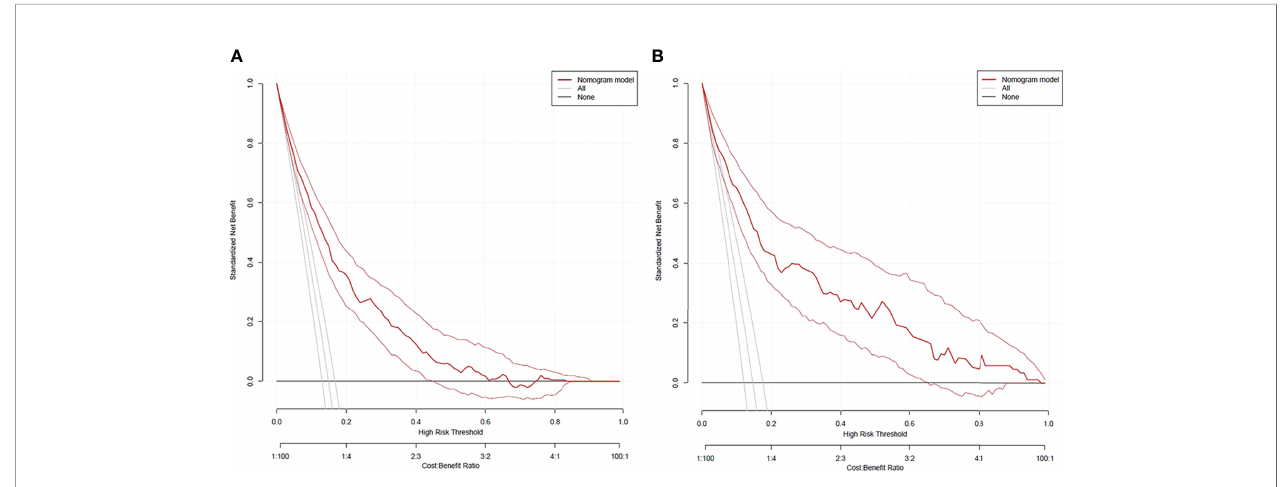
FIGURE 5 | DCA curves of the nomogram prediction for the risk of diabetic foot in patients with T2DM in the training cohort (A) and validation cohort (B)